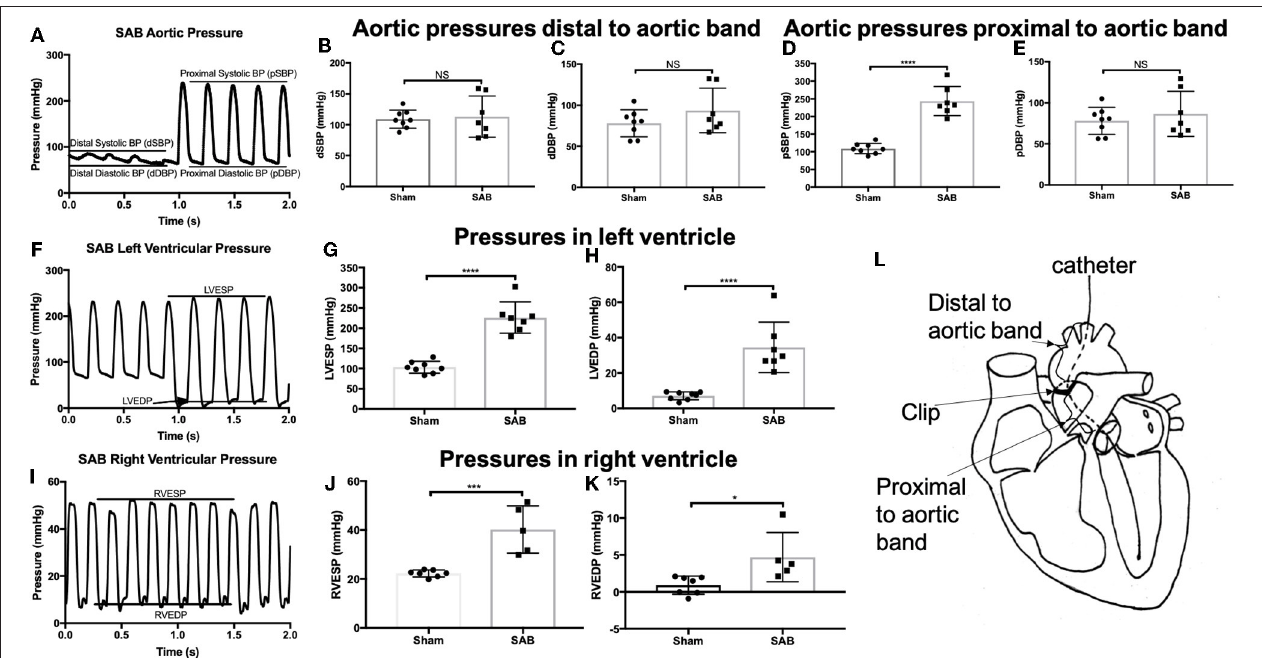
FIGURE 2 | Hemodynamic studies of sham vs. SAB rats. Left carotid catheterization showing (A) hemodynamic measurement of (B) systolic, and (C) diastolic blood pressure distal to the band (dSBP and dDBP) and (D) systolic and (E) diastolic blood pressure proximal to the band (pSBP and pDBP). Left heart catheterization showing (F) hemodynamic measurement of (G) left ventricular end systolic pressure (LVESP) and (H) left ventricular end diastolic pressure (LVEDP). Right heart catheterization showing (I) hemodynamic measurement of (J) right ventricular end systolic pressure (RVESP) and (K) right ventricular end diastolic pressure (RVEDP). (L) Schematic drawing showing the anatomical definition of distal and proximal to aortic band.